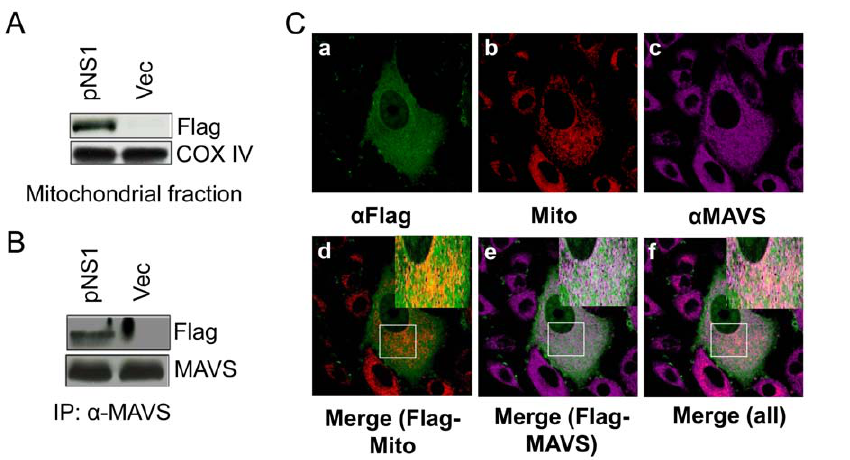
Figure 6. RSV NS1 is present on the mitochondria and co-immunoprecipitates with MAVS in NS1-transfected cells. ( A ). A549 cells were transfected with pNS1-Flag (NS1) or pFlag (Vec). Mitochondria were isolated and the proteins were analyzed by western blot for Flag and Cox-IV ( B ). Total cell extracts were immunoprecipitated with anti-MAVS antibody and analyzed by western blotting with anti-Flag and anti-MAVS antibodies. ( C ). A549 cells transfected with pNS1-Flag were stained for Flag (green, a ), mitochondria (CMXRos, red, b ), and MAVS (purple, c ) and visualized using the Leica TCS SP2 laser scanning confocal microscope. The squares in d and e show co-localization of NS1 with mitochondria and MAVS respectively, and the box in f shows co-localization of NS1, MAVS and mitochondria. The insets in d,e , and f show the enlargement of the indicated areas.